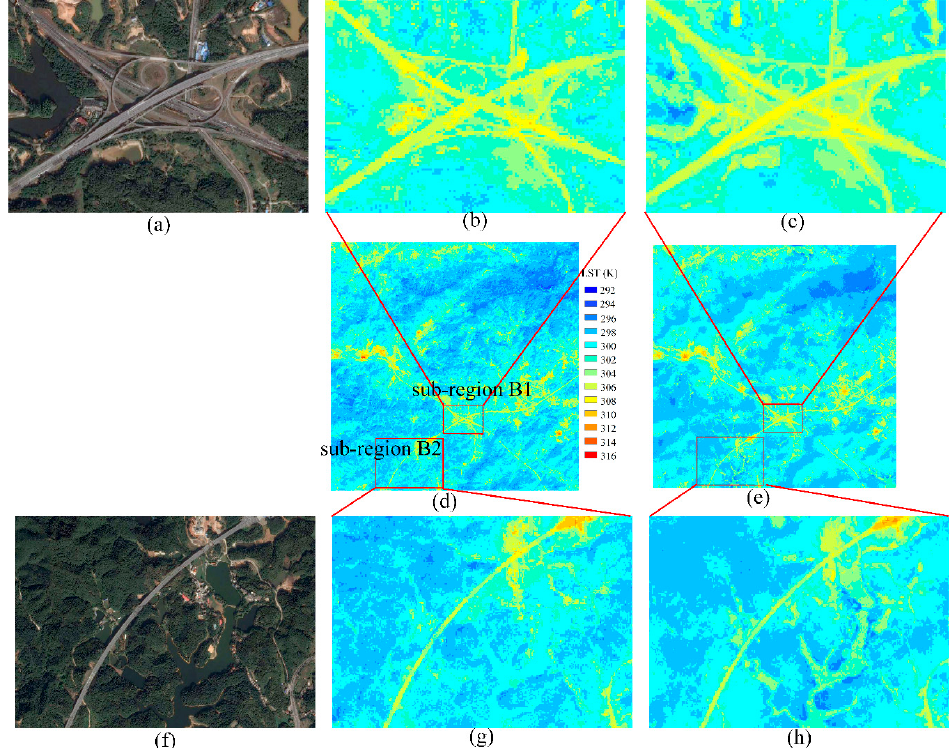
Figure 13. Downscaled LSTs of the RFATPK and the TsHARP for region B. ( a and f ) High-spatial resolution images from Google map; ( b and c ) 10 m RFATPK and TsHARP downscaled LSTs for subregion B1; ( d and e ) 10 m RFATPK and TsHARP downscaled LSTs for region B; ( g and h ) 10 m RFATPK and TsHARP downscaled LSTs for subregion B2.